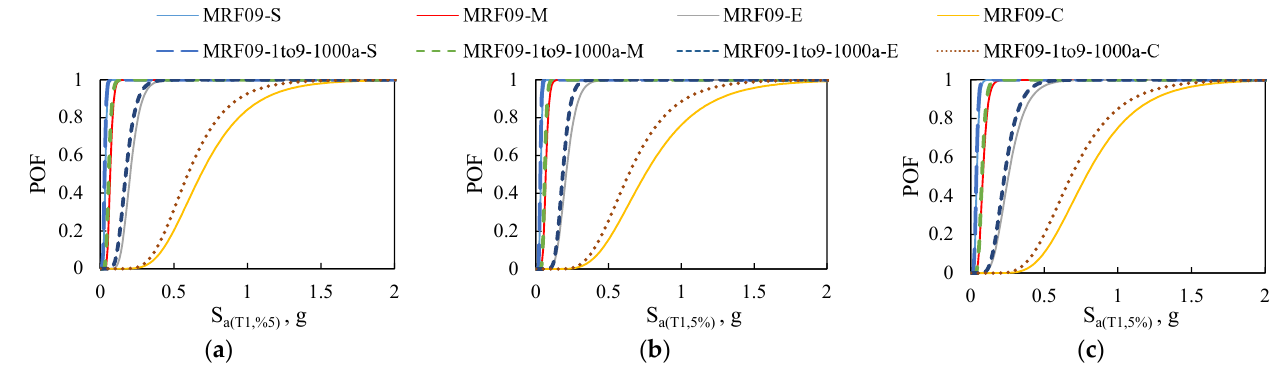
Figure 11. Fragility curves of 9-story structure subjected to ( a ) FF, ( b ) NF-No Pulse, and ( c ) NF-Pulse records, respectively.